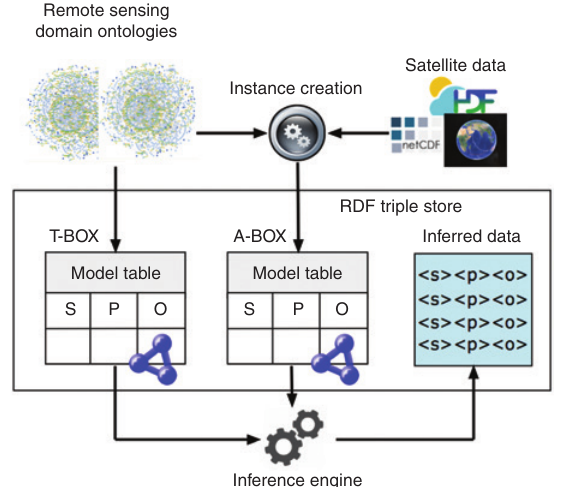
Figure 4: Strategy 2: Ontology Concept-Based Satellite Data